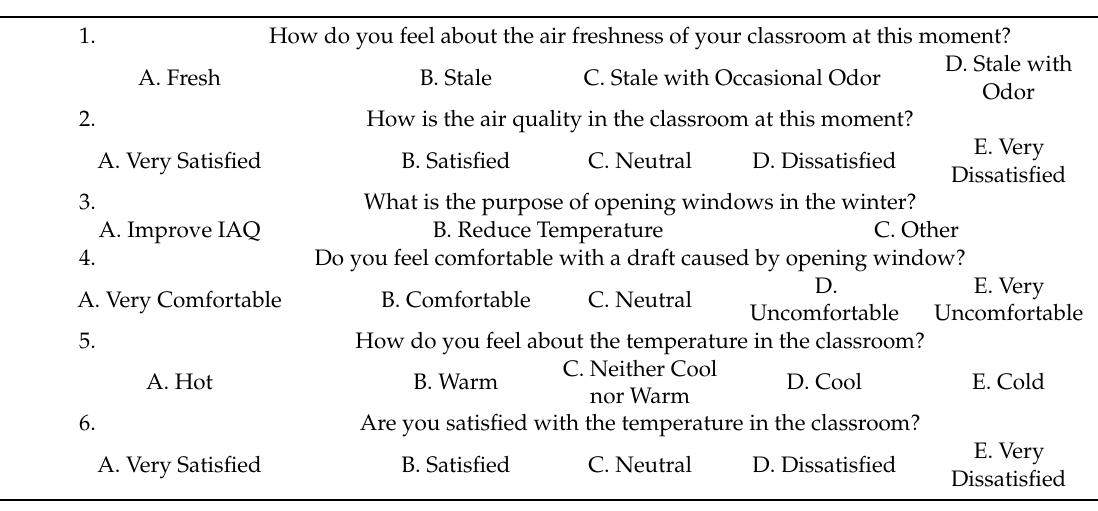
Table 4. The survey